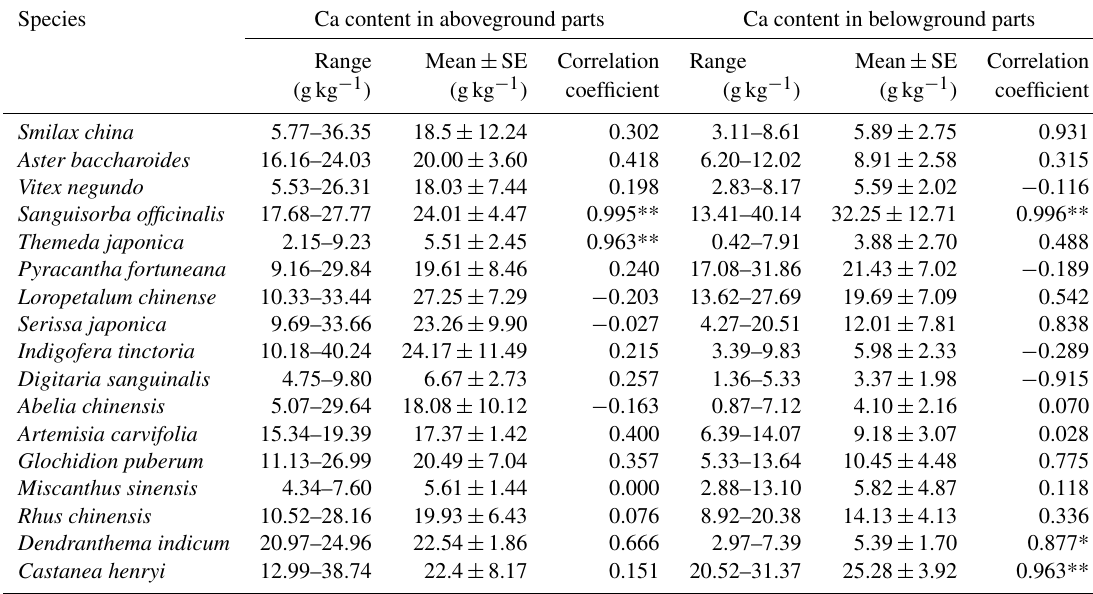
Table 4. Correlations between the Ca content of 17 plant species and the soil ECa content of different rocky desertification areas. Species